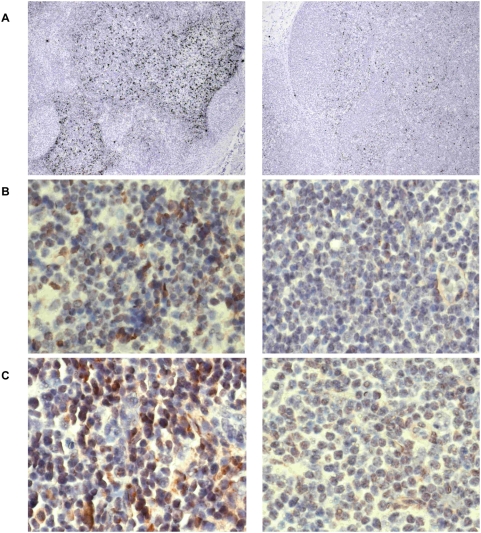
Downregulation of CCL21 in draining lymph nodes 18 hours after immunization with KLH plus poly ICLC.(A) Expression of CCL21 mRNA (determined by in situ hybridization) in control lymph nodes before (black dots, left panel) and in draining lymph nodes (right panel) 18 hours after KLH-immunization with 0.5 mg/kg poly ICLC; in situ hybridization, 100× magnification. (B,C) Cells positive for CCL21 protein expression (determined by immunohistochemistry) are visible in brown in the T cell areas of control lymph nodes (left panels) and of draining lymph nodes (right panels) after immunization with KLH plus 0.5 mg/kg (B) or 0.1 mg/kg (C) poly ICLC; 400× magnification.